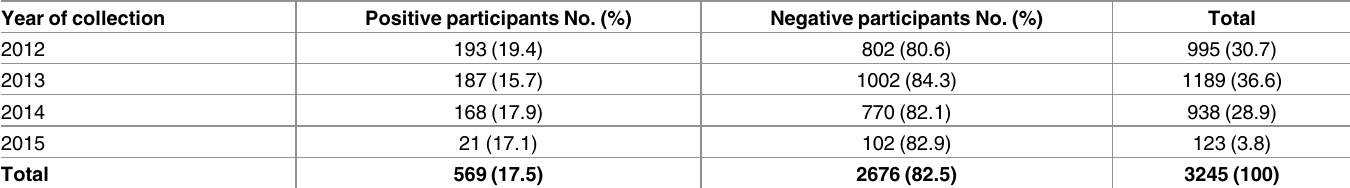
Table 2. Prevalence of intestinal parasites along the yearsof the survey.